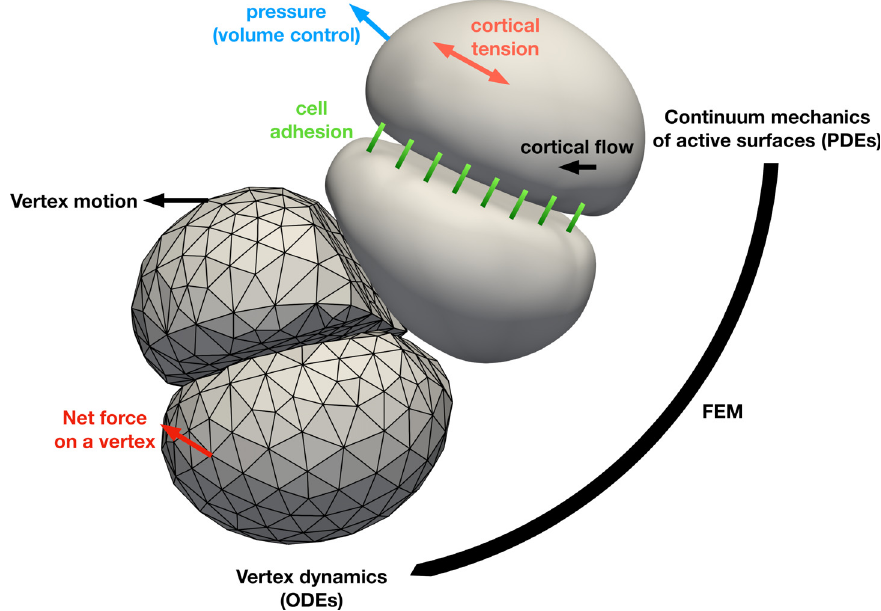
Fig 1. Schematic of the interacting active surface framework. A tissue is described by a collection of triangular meshes representing each cell. The dynamics of the tissue is described by the dynamics of the vertices making the cellular meshes, similar to how the movement of the vertices of a vertex model describe the deformation of a tissue. The motion of the cell mesh is obtained by coarse-graining continuum mechanics equations of a theory of active surfaces via the finite element method. In this theory, cortical flows, cortical tensions, intracellular pressures, bending moments and forces arising from cell-cell interactions are taken into